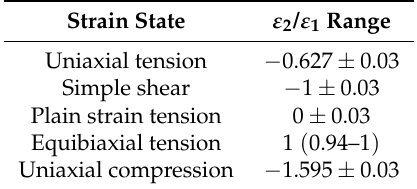
Table 5. ε 2 / ε 1 range characterizing the different strain